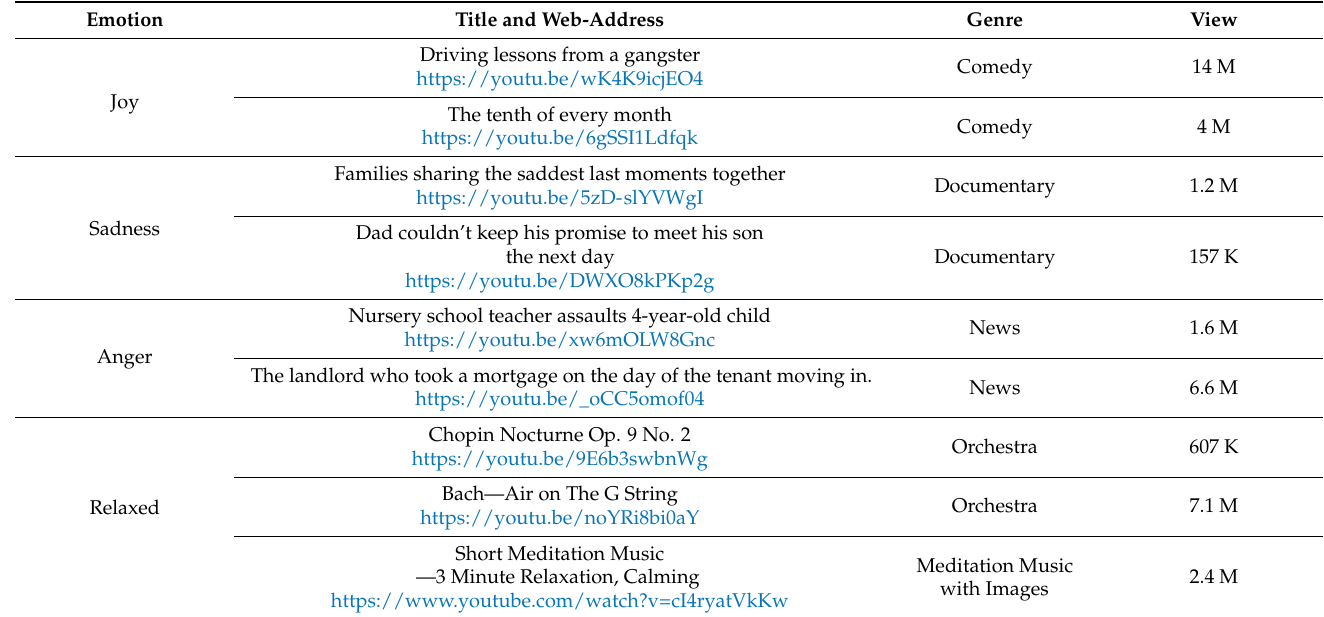
Table 2. Video stimuli information (video links were accessed 7 April 2022